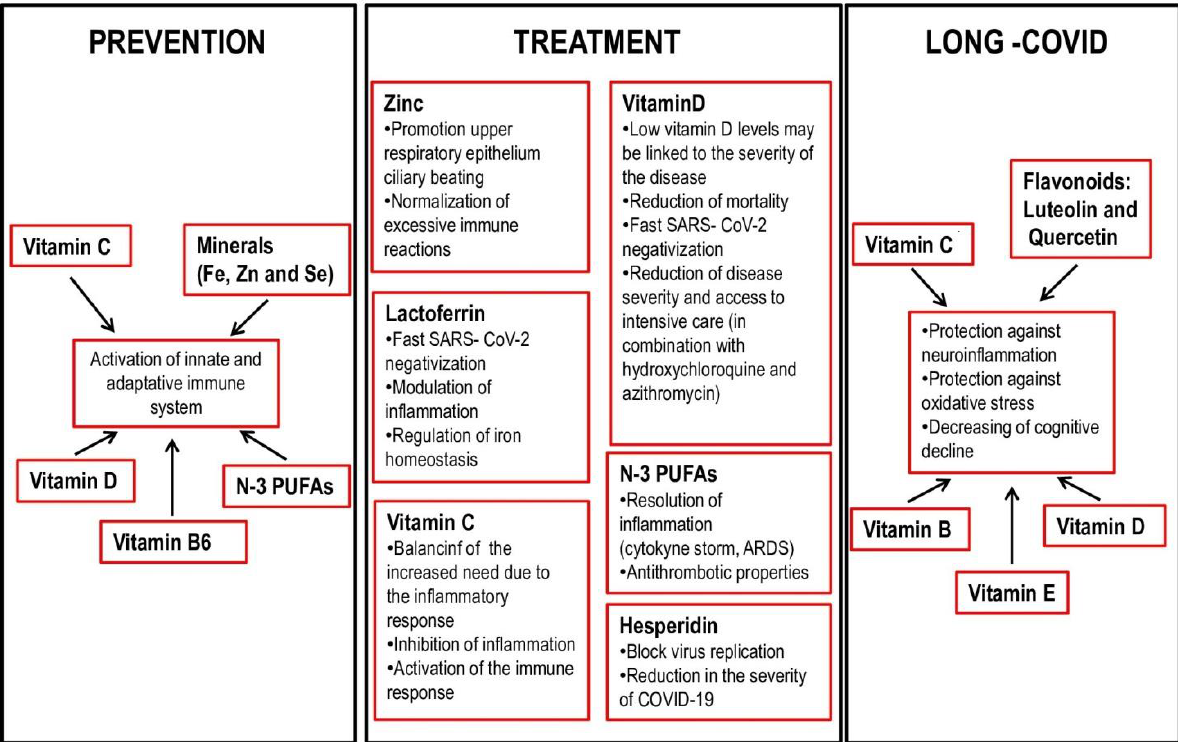
Figure 2. Functions of nutrients in prevention, treatment and post-COVID 19.